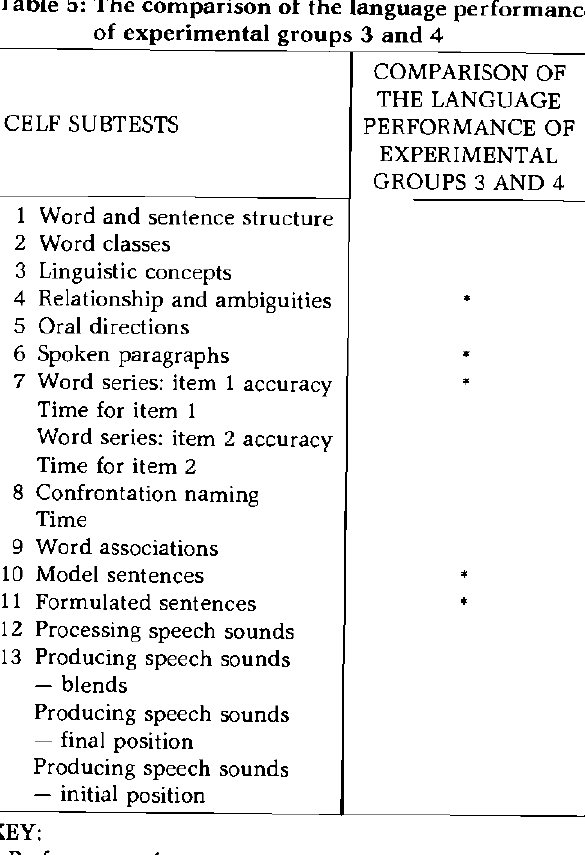
Table 5: The comparison of the language